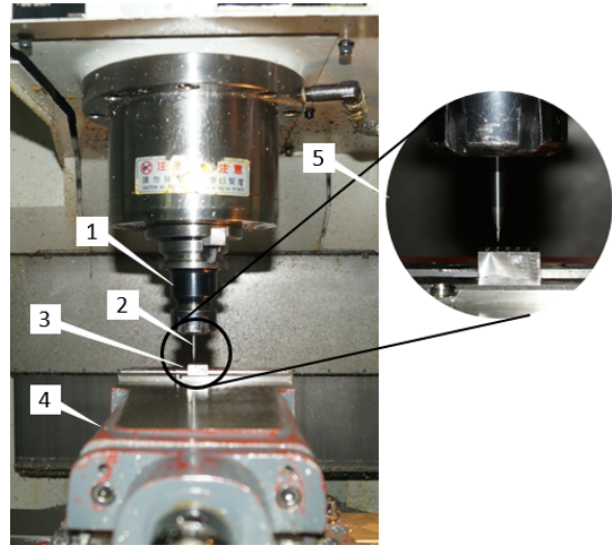
Figure 3. Experimental Setup (1) Spindle; (2) Micro end mill; (3) Workpiece; (4) Machining vise; (5) Magnified view of tool and